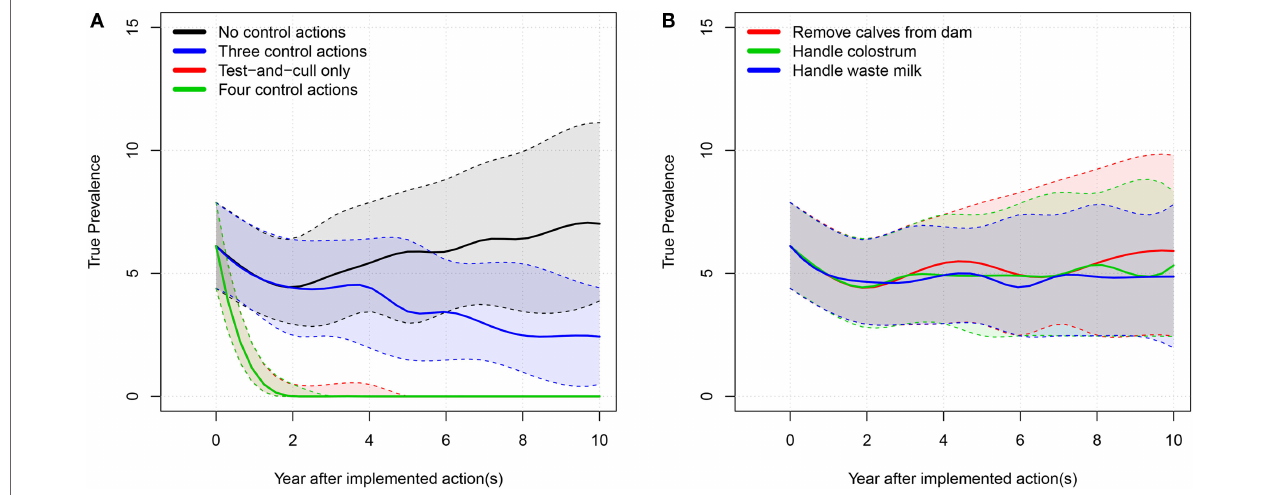
FIGURE 2 | True prevalence: 50% simulation envelope over 10 simulated years for the tested scenarios in the average-hygiene herd . (A) “Three control actions” means the three control actions in (B) . “Four control actions” means the three actions in B plus test-and-cull. (B) “Handle waste milk” and “handle colostrum” means that the farmer only uses milk or colostrum from test-negative cows for feeding calves.